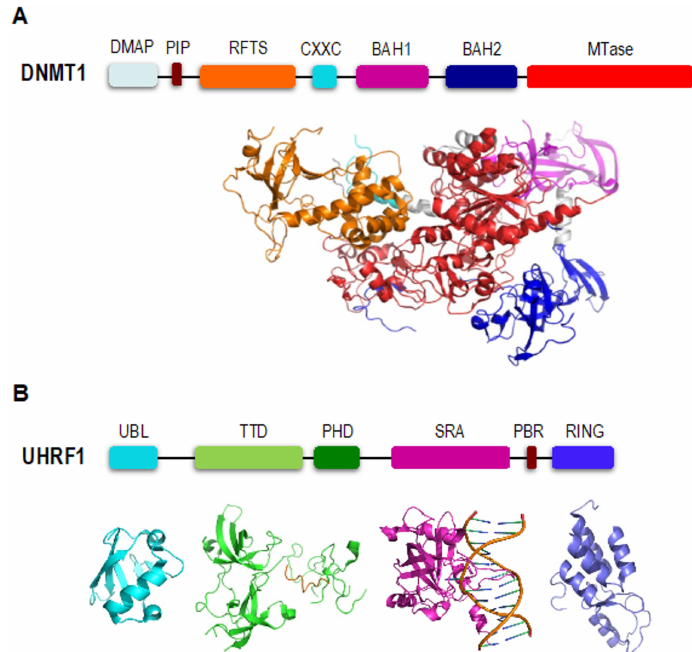
Figure 1. Structures of DNMT1 and UHRF1. ( A ) Domain architecture of DNMT1 and crystal structure of human DNMT1 (aa: 351-1600; PDB: 4WXX) [23]. ( B ) Domain organization of UHRF1 and crystal structures of mouse UHRF1 UBL domain (PDB: 2FAZ), TTD-PHD in complex with H3K9me3 peptide (PDB: 3ASK), SRA in complex with hemi-methylated DNA fragment (PDB: 3CLZ) and UHRF1 RING finger (PDB: 3FL2)